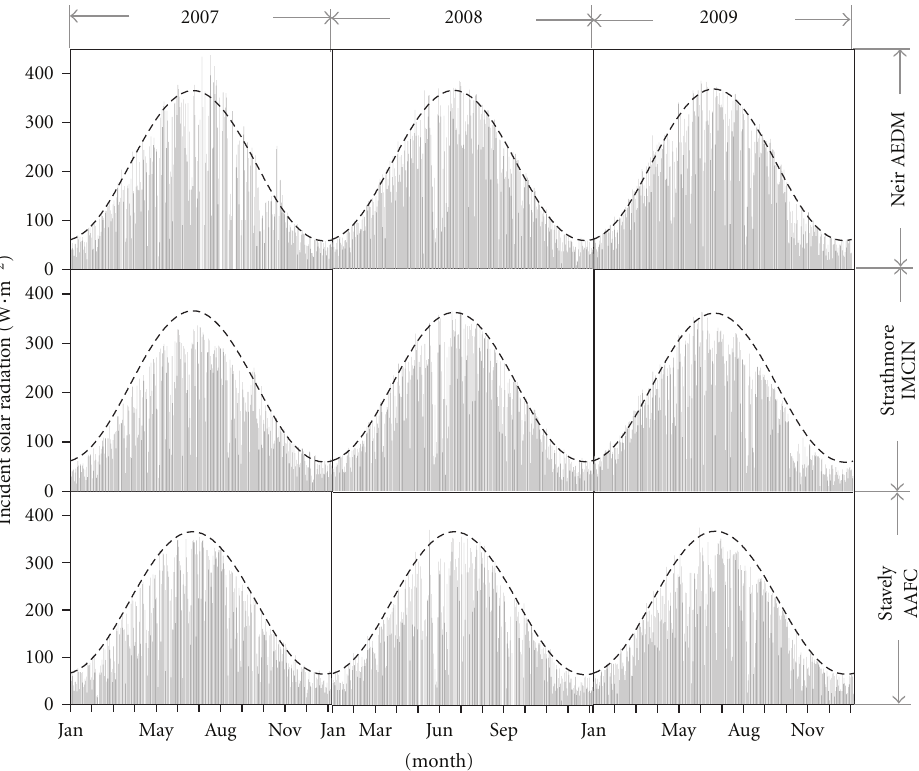
Figure 4: Comparison between modelled daily potential (black dashed lines) and ground-based measurements (gray vertical lines) of incident solar radiation at the locations of Neir AEDM, Strathmore IMCIN, and Stavely AAFC for the period of